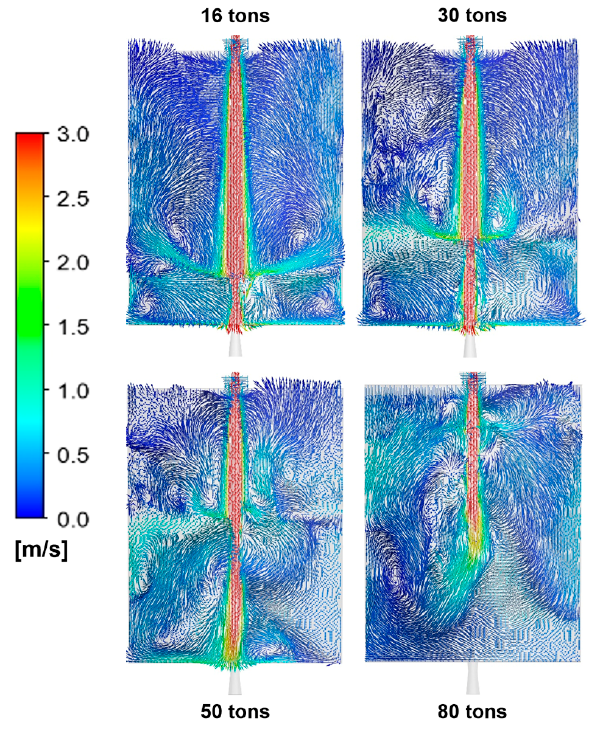
Figure 4. Velocity profiles in the symmetry-impinging planes (Central plane) at different bath levels in the ladle with simultaneous argon bottom stirring. the ladle with simultaneous argon bottom stirring.